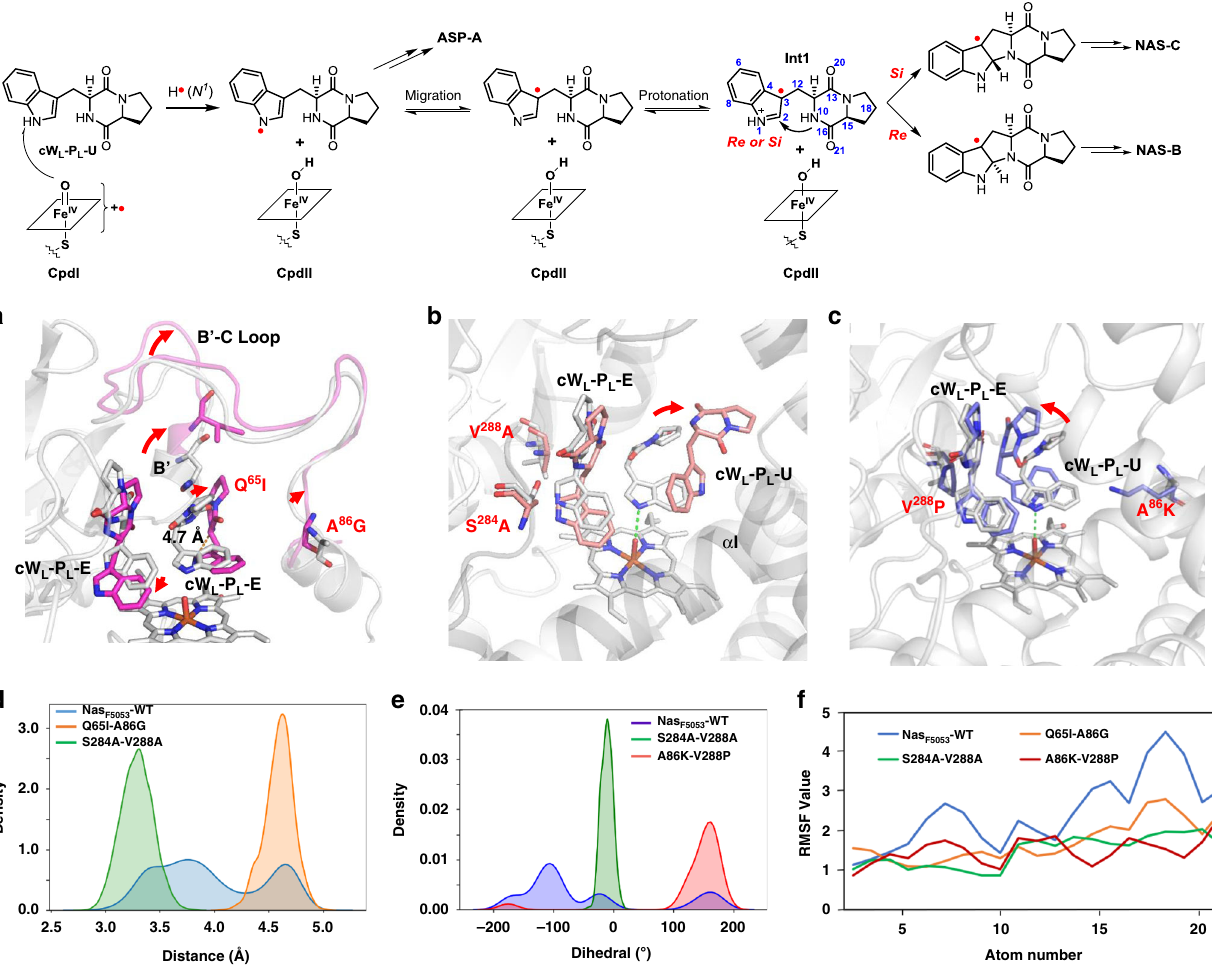
Fig. 4 Molecular dynamics (MD) simulations of Nas F5053 (WT), Nas F5053 -Q65I-A86G, Nas F5053 -S284A-V288A and Nas F5053 -A86K-V288P in the presence of the substrate cWL-P L -E and the cW L -P L -U radical (Int1). CpdI and CpdII are compound I and compound II, respectively. In a cartoon representation, selected active site residues are shown as sticks. a Superposition of WT Nas F5053 (gray) and Nas F5053 -Q65I-A86G (pink). b Superposition of WT Nas F5053 (gray) and Nas F5053 -S284A-V288A (salmon pink). c Superposition of WT Nas F5053 (gray) and Nas F5053 -A86K-V288P (cyan). d Distances between N 10 and C 2 of the cW L -P L -U radical in WT Nas F5053 (blue), Nas F5053 -Q65I-A86G (orange), and Nas F5053 -S284A-V288A (green). e C 2 – C 3 – C 12 – N 10 dihedral angles of the cW L -P L -U radical in WT Nas F5053 (blue), Nas F5053 -S284A-V288A (green), and Nas F5053 -A86K-V288P (red). f RMSF values of the cW L -P L -U radical in WT Nas F5053 (blue), Nas F5053 -Q65I-A86G (brown), Nas F5053 -S284A-V288A (green), and Nas F5053 -A86K-V288P (red). For atom numbers, see the cW L -P L -U radical (int1) in the top